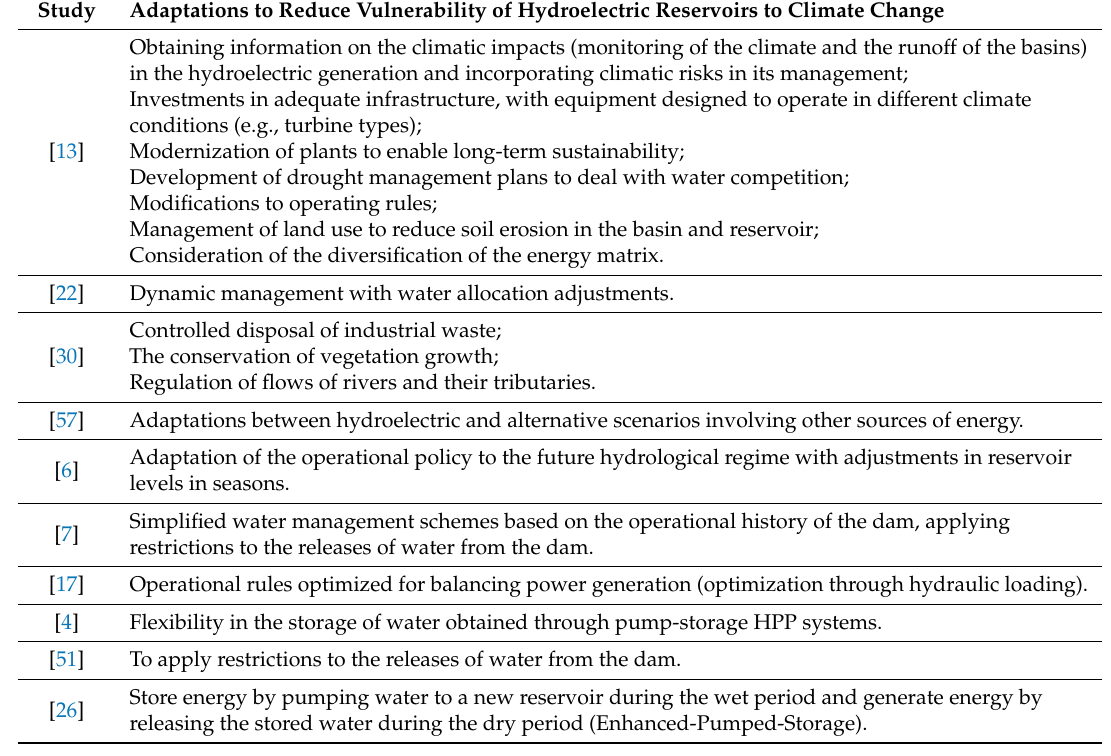
Table 4. Adaptations to reduce vulnerability of hydroelectric reservoirs to climate